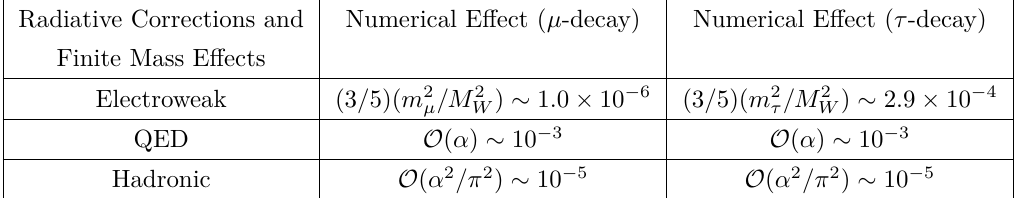
Table 5. Main numerical effects of radiative corrections.